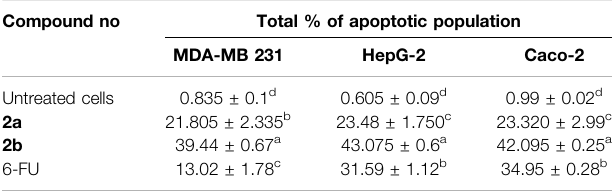
TABLE 5 | Apoptotic cell population percentagesin 2a- and 2b- treated MDA-MB 231, HepG-2, and Caco-2 cells. Compound